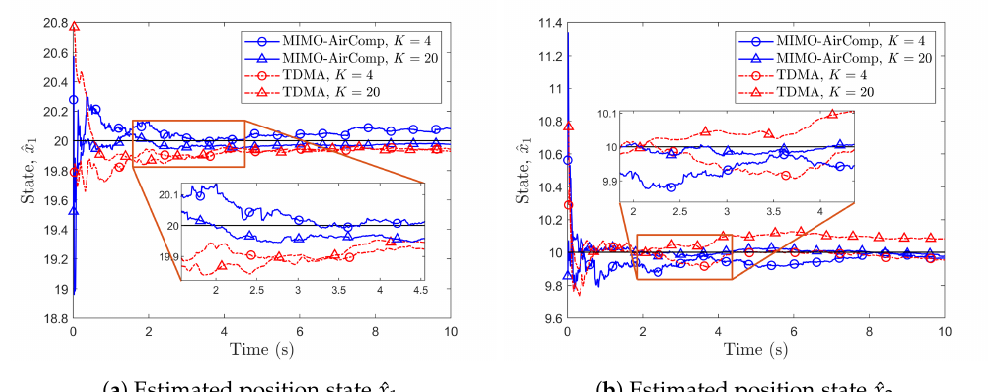
Figure 2. Estimated position states ˆ x 1 and ˆ x 2 of the MIMO-AirComp and TDMA with different numbers of beacon nodes K = 4,20 over